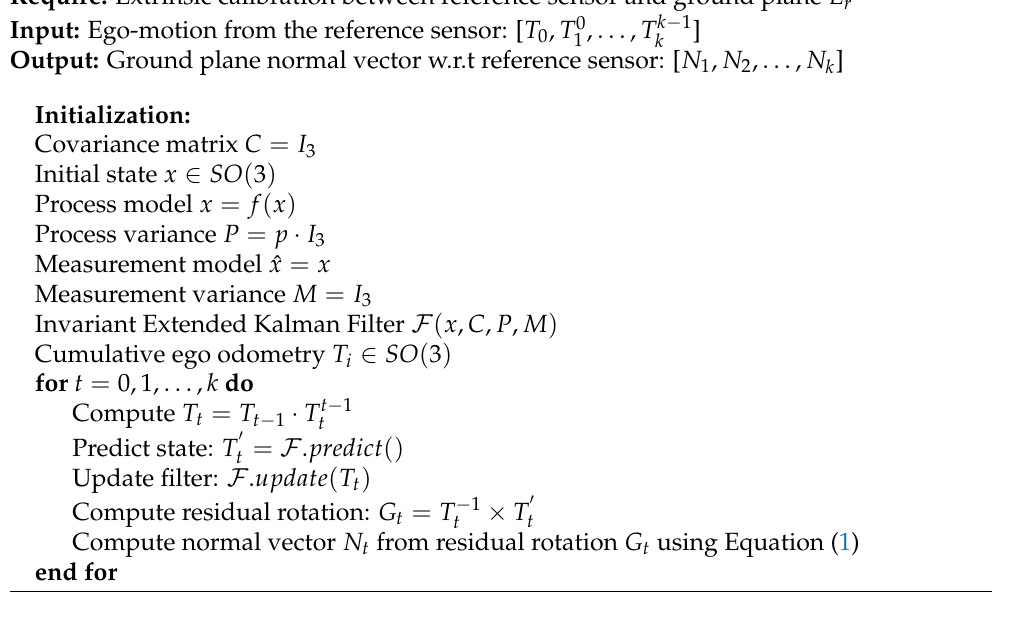
Algorithm 1 Ground Plane Normal Vector